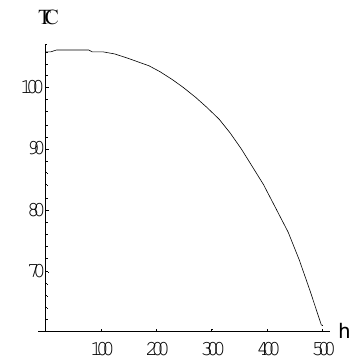
Fig 7.(b) The effect of parameter η on the total cost in the fuzzy